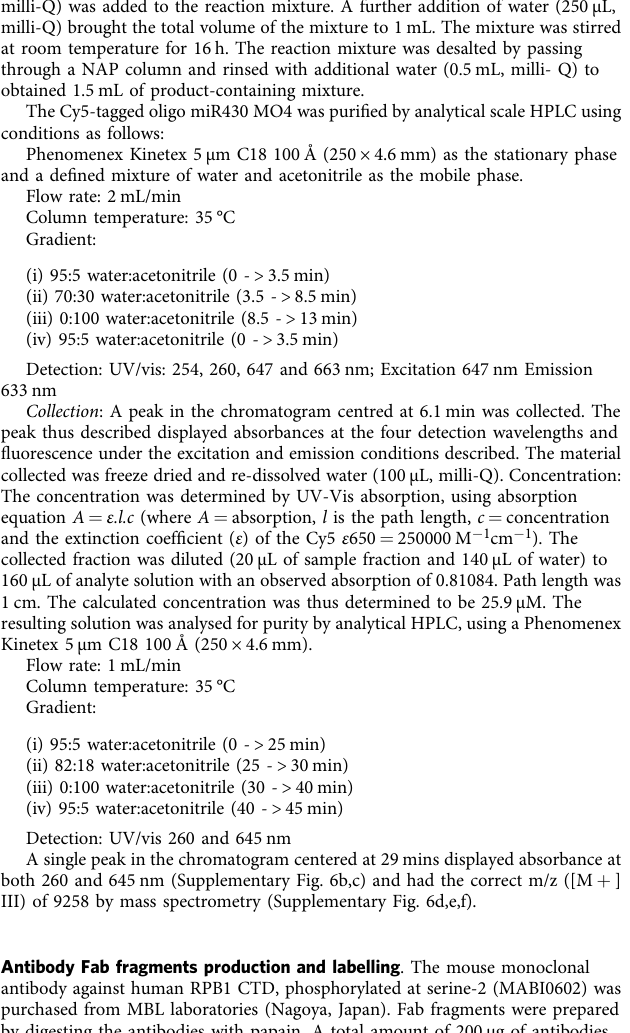
quad venn-diagram graphic (Supplementary Fig. 4c) was generated with VennDiagram CRAN R package 67 . Synthesis of Cy5-tagged miR430 MO4 morpholino . Unless otherwise stated materials and reagent were used as supplied by Sigma-Aldrich and Fisher Scienti fi c. Morpholino sequence (I) bearing 3 ′ -alkyne functionality attached by propyl acetate linker were obtained from Gene Tools Ltd and used as supplied. Desalting was conducted using NAP-10 columns (GE Healthcare). HPLC analysis and puri fi ca- tion was carried out using a Shimadzu LC2010 with a Phenomenex Kinetex 5 µm C18 100 Å (250×4.6mm) column. Mass spectrometry was conducted on a SYNAPT G2-S instrument using TOF MS ES + with a solvent mixture of 50:50 water/acetonitrile containing formic acid (0.1% v/v). UV absorption spectroscopy was conducted on Shimadzu UV-180 UV spectrophotometer. Solvents used were of HPLC grade, Milli-Q water is ultrapure water supplied by Millipore Corporation. An alkyne-tagged miR430 MO4 sequence (I) was exposed to azide-tagged Cy5- fl uorophore II under copper-catalysed triazole-forming conditions to deliver Cy5- tagged sequence III. Fluorescein-tagged morpholino sequence IV (and alkyne- tagged sequence I) were supplied by Gene Tools Ltd. The conversion to III is detailed in Supplementary Fig. 6a. Tris(3-hydroxypropyltriazolylmethyl)amine (THPTA) (11mg, 25.5 µmol), sodium abscorbate (5.3mg, 27µmol) copper sulphate (0.94mg, 3.75 µmol) and a magnetic stirring bead were placed in a 2mL vial. 3 ′ -Alkyne morpholino